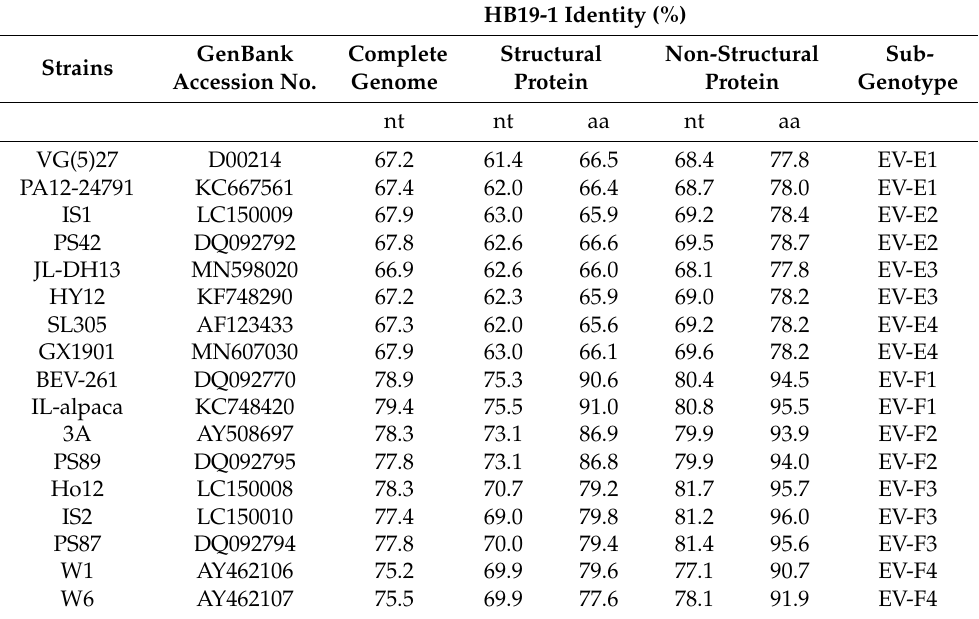
Table 1. Nucleotide and amino acid sequences and identity analysis of HB19-1 and the other BEV strains. HB19-1 Identity (%) GenBank Complete Strains Accession No. Genome